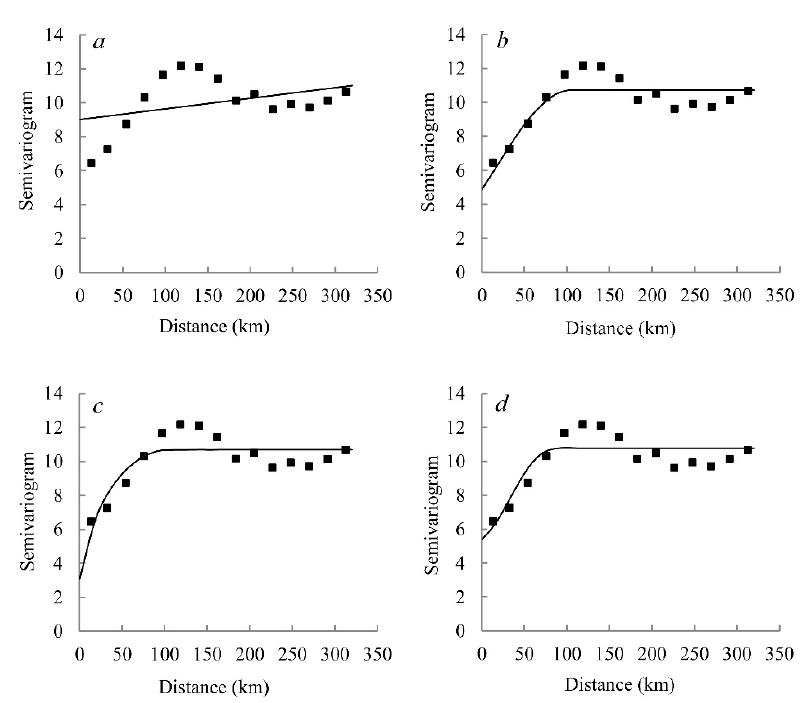
Figure 6. Semivariograms of vegetation carbon density (including tree, understory vegetation and litter layers) in Pinus massoniana forest in the Jiangxi Province. ( a ), ( b ), ( c ), and ( d ) represent linear model, spherical model, exponential model and Gaussian model, respectively.